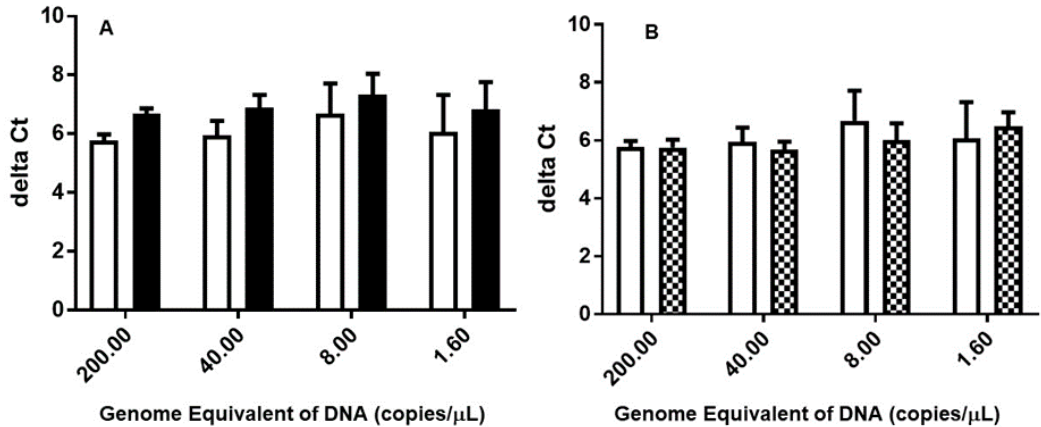
Figure 1. Comparison of Δ Ct in Orientia DNA using Ct determined by the 47 kDa and traD qPCR. Genomic DNA was extracted from Leptotrombidium chiangraiensis (Lc) (open bars in Panel A and B ) chigger mites, Lc chiggers infected mouse liver (black bars in Panel A ) or Leptotrombidum impalum (Li) (hashed bars in Panel B ) chigger mites as described. The extracted DNA was diluted to the appropriate concentration according to the GE determined based on the 47 kDa gene as described in Materials and Methods. Δ Ct was calculated by subtracting the Ct determined using the traD gene from that determined using the 47 kDa gene at a given GE. The difference in Δ Ct between the DNA extracted from different sources was not statistically significant.